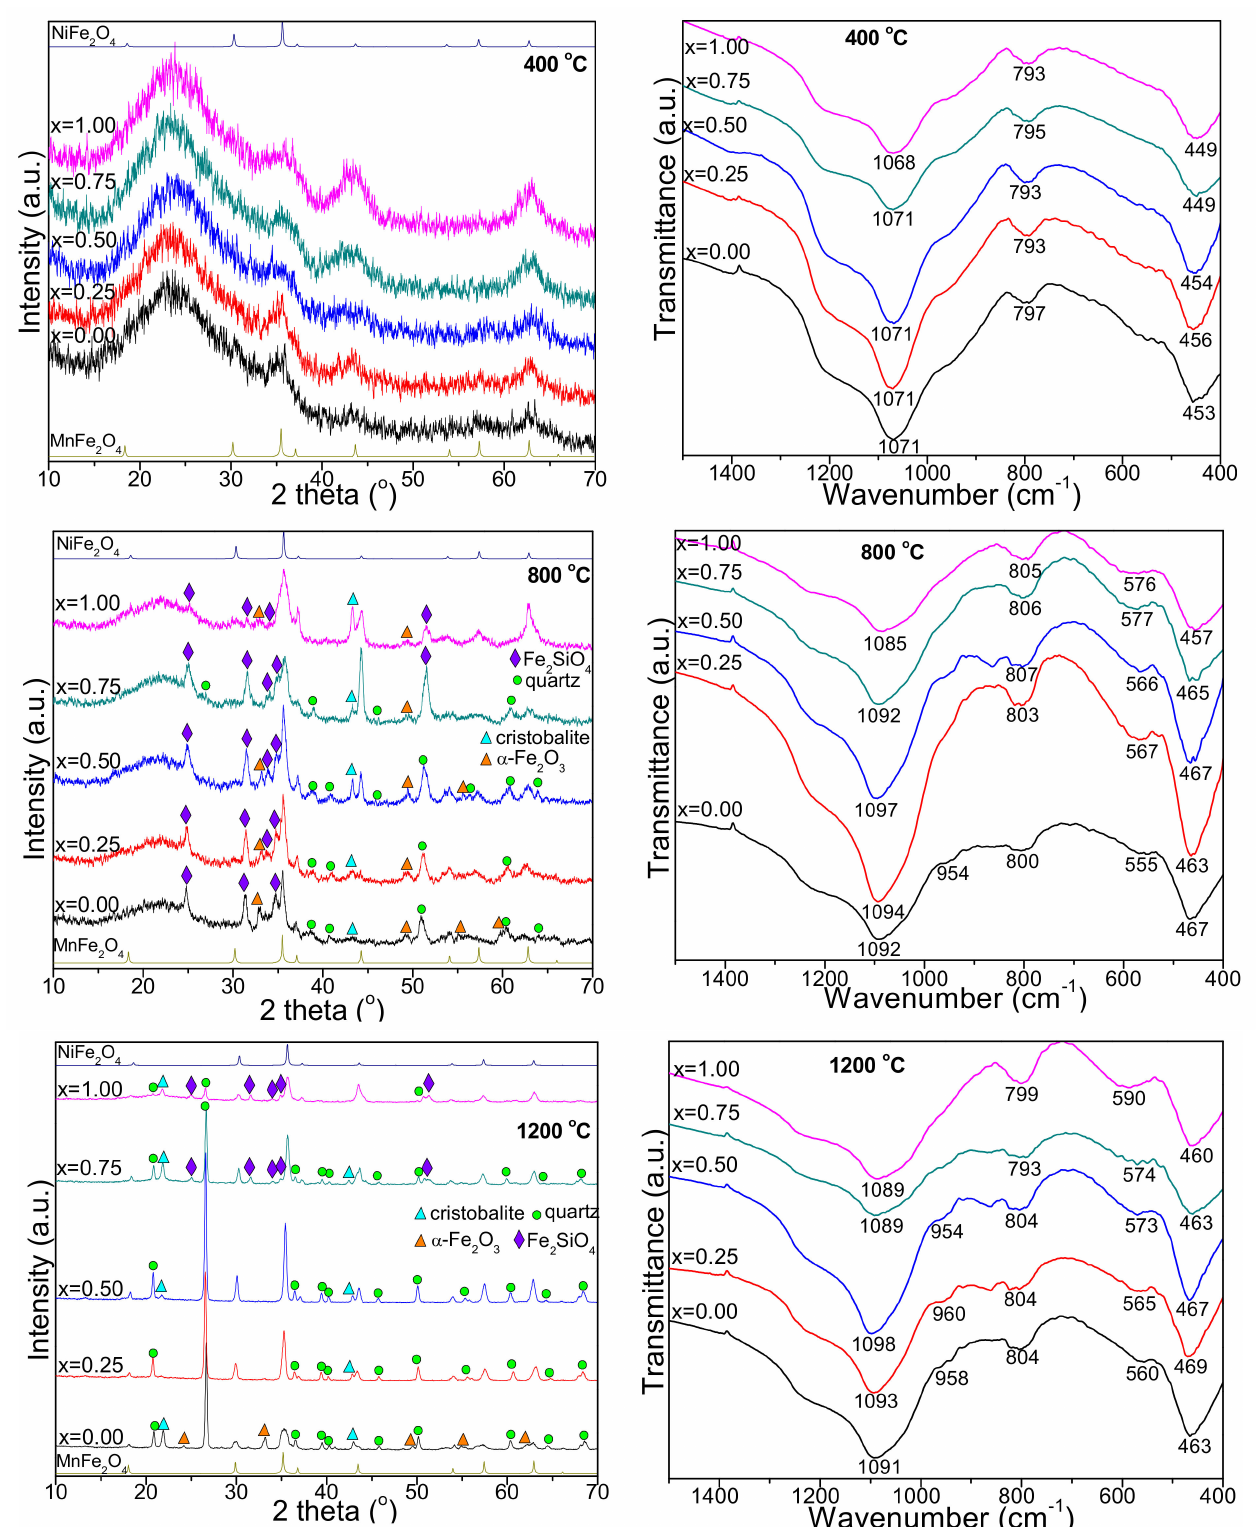
Figure 1. X-ray diffraction patterns and FT-IR spectra of Mn1 − x Ni x Fe 2 O 4 @SiO 2 NCs annealed at 400, 800, and 1200 ◦